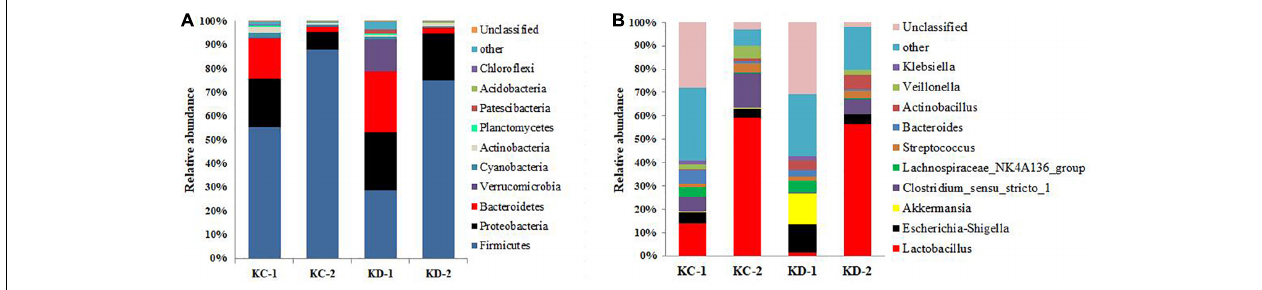
FIGURE 1 | Bacterial community composition of jejunal digesta. (A) Phylum level; (B) genus level. KC-1: bacterial composition of jejunal digesta sampled from Hoxa1 − / − neonatal piglets delivered by sows administered with ATRA, KC-2: bacterial composition of jejunal digesta sampled from non-Hoxa1 − / − neonatal piglets delivered by sows administered with ATRA, KD-1: bacterial composition of jejunal digesta sampled from Hoxa1 − / − neonatal piglets delivered by sows administered without ATRA, KD-2: bacterial composition of jejunal digesta sampled from non-Hoxa1 − / − neonatal piglets delivered by sows administered without ATRA.